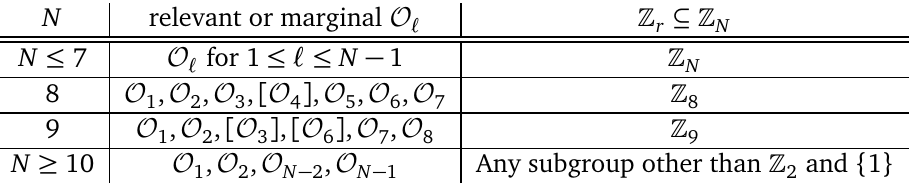
Table 1: Relevant and marginal deformations in the SU ( N ) operators are in the square brackets. The operator O Λ (cid:96)